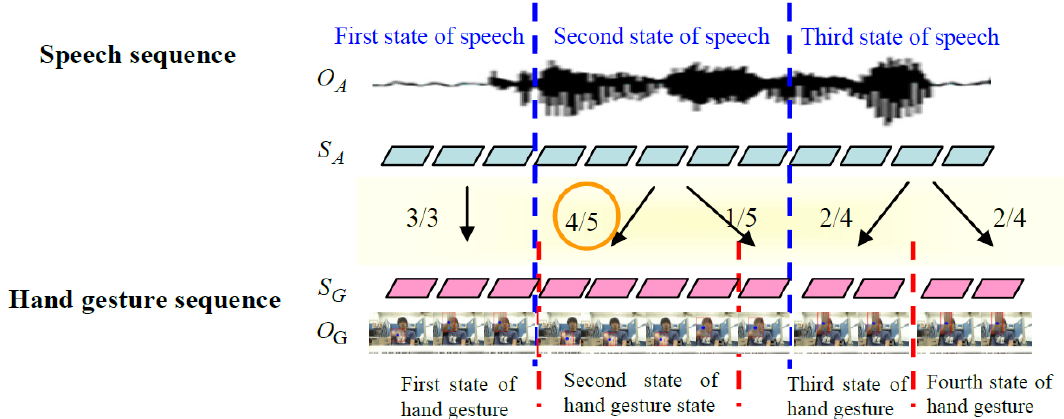
Figure 19. Correspondence between state sequences of speech and hand gesture.